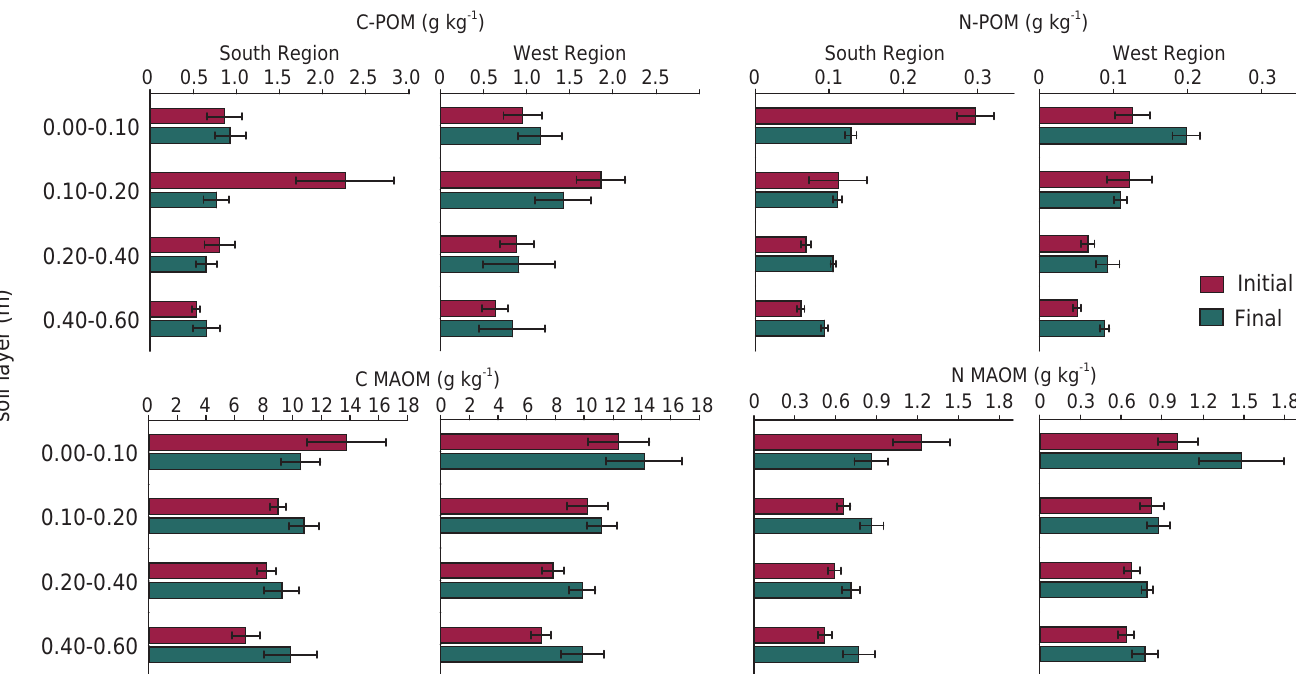
Figure 4. Carbon (C) and nitrogen (N) content in particulate organic matter (POM) and mineral-associated remover soil organic matter (MAOM) soon after application of 50 kg ha -1 N (initial) and at 36 months (final). Bars in each column represent standard deviation of the